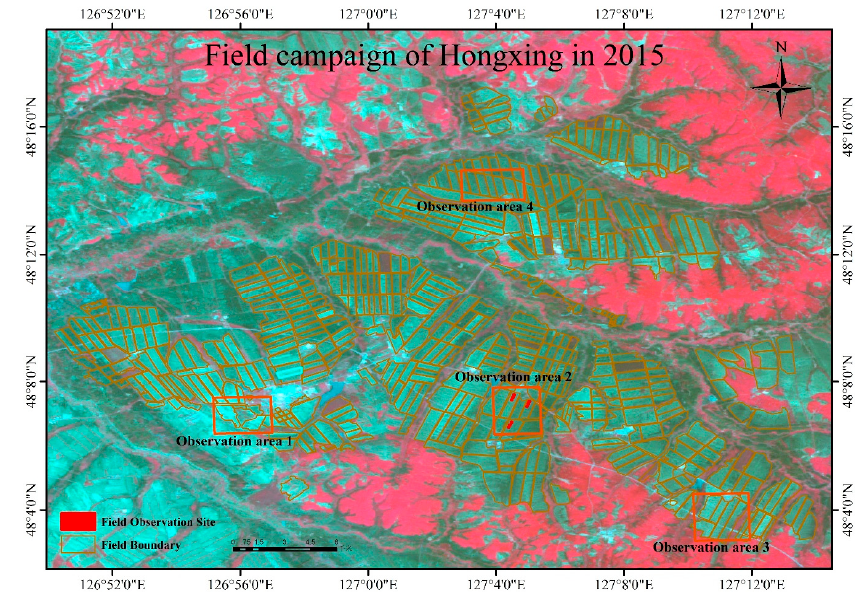
Figure 2. Observation areas of Hongxing in 2015.